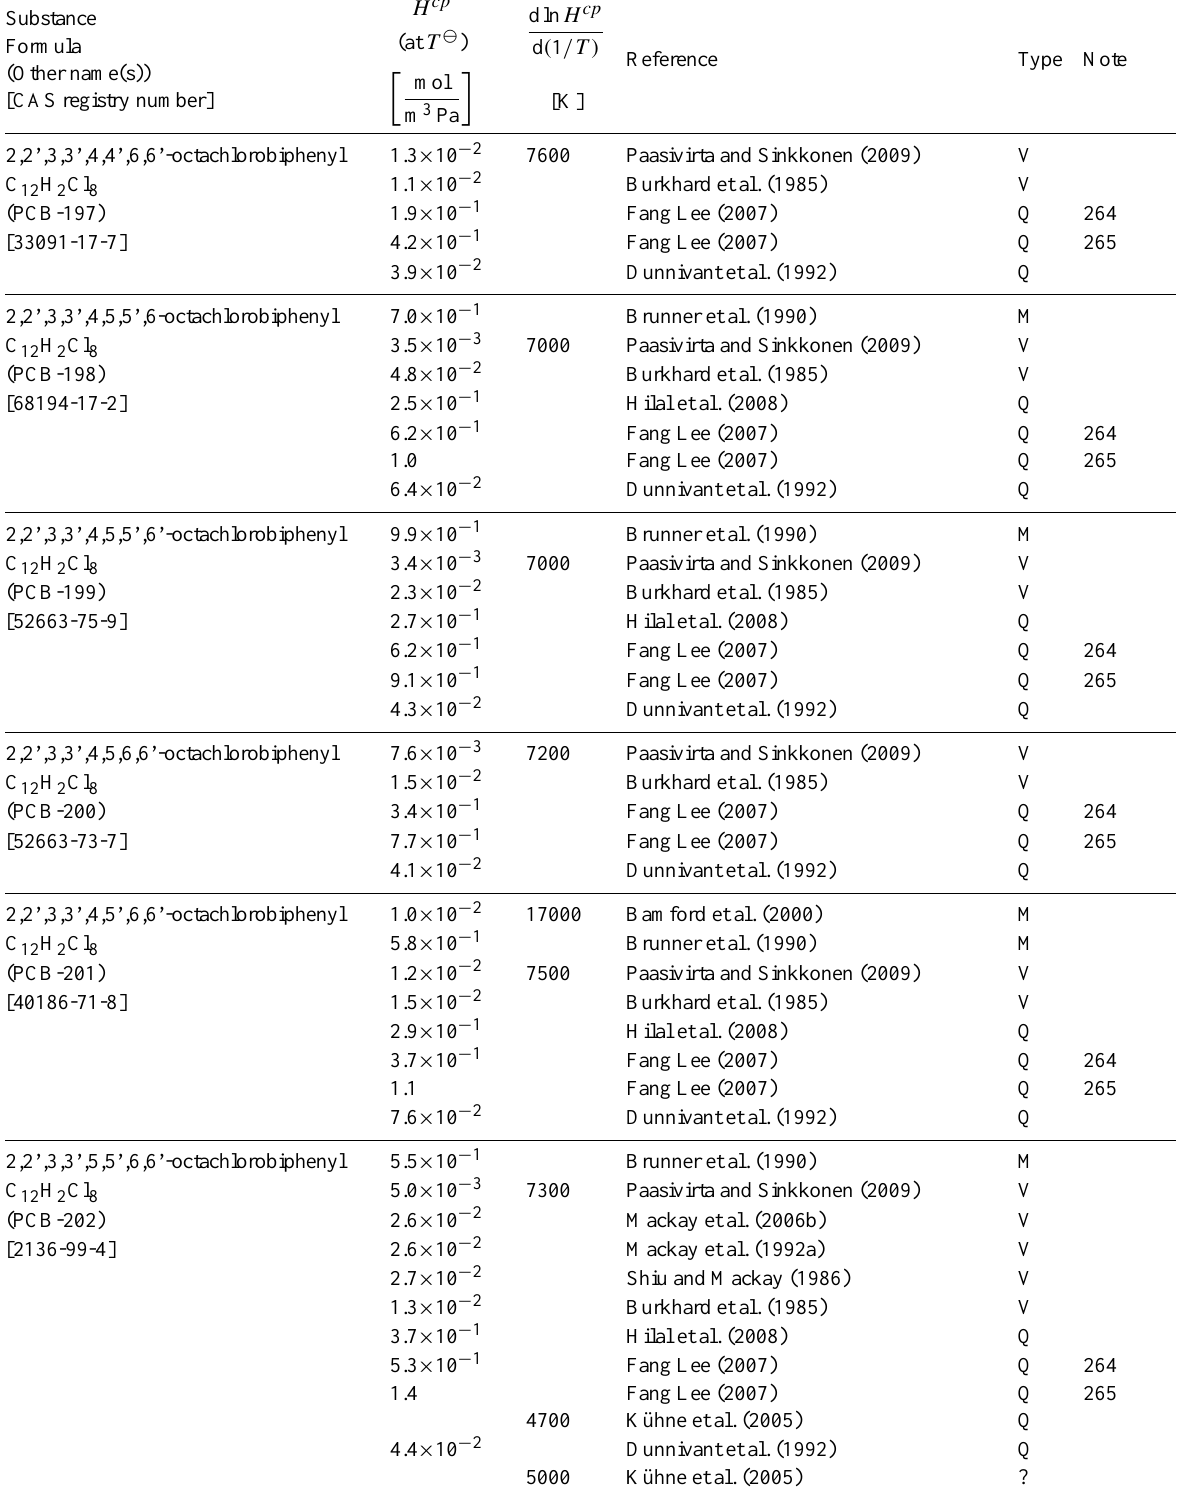
Table 6: Henry’s law constants for water as solvent